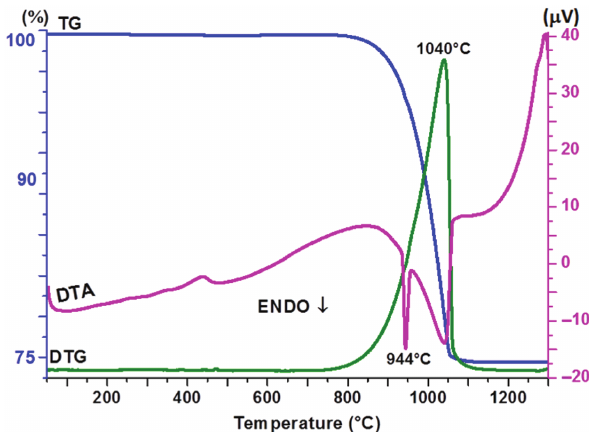
Figure 1: DTA/TG/DTG curves of Sr 3 SiO 5 : Eu 3 + , Dy 3 + .